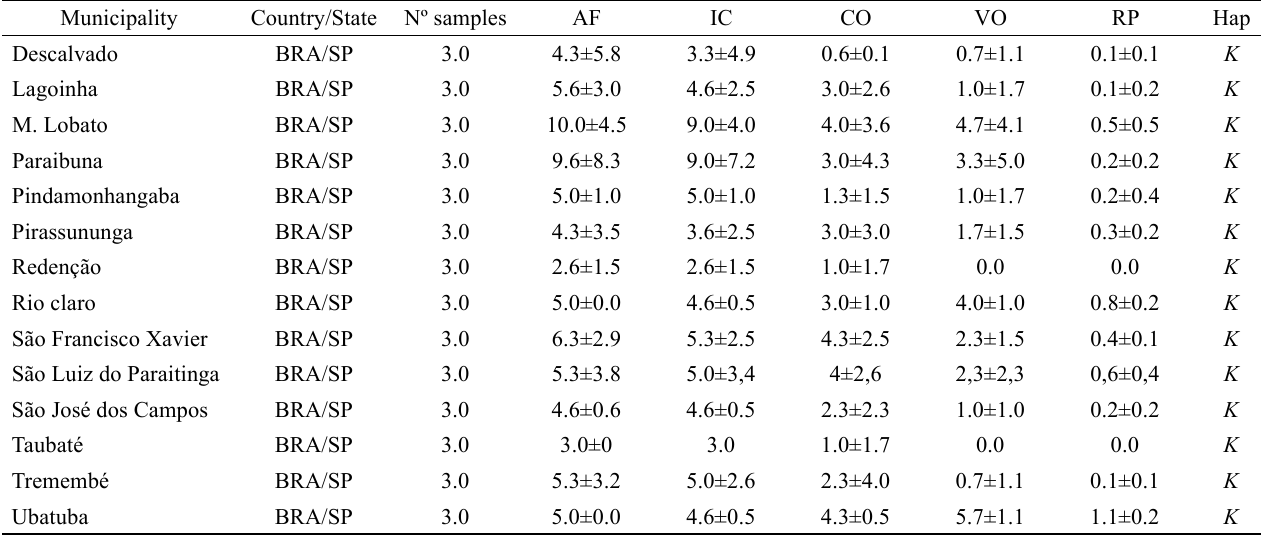
Table 1 . Reproductive and genetic parameters of worker brood cells infested with Varroa destructor (mean ± sd): AF – adult female mite (total), IC – infested brood cells (%), CO – brood cells infested with offspring (%), VO – viable offspring (total), RP – reproductive potential (total) and Hap – haplotype.